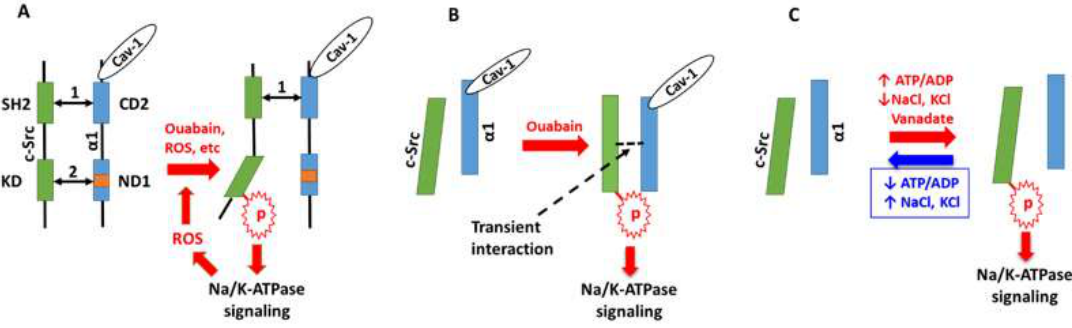
Figure 2. Schematic illustration of different working models. In the illustration, ouabain is used as a representative of cardiotonic steroids. ( A ) The model of Na/K-ATPase/c-Src (binding) receptor complex. Binding between c-Src SH2 domain and α1 CD2 segment as well as c-Src KD domain and α1 ND1 segment are indicated by arrow 1 and 2, respectively. ( B ) the model of c-Src activation by transiently binding to Na/K-ATPase/Cav-1 complex; ( C ) the model of c-Src activation regulated by the ATP/ADP ratio, ATPase inhibitor vanadate, and low concentrations of Na + and K + . In this model, there is no binding between Na/K-ATPase and c-Src. The role of Cav-1 was not tested. Please refer to the references for details. Cav-1, caveolin-1; ROS, reactive oxygen species.